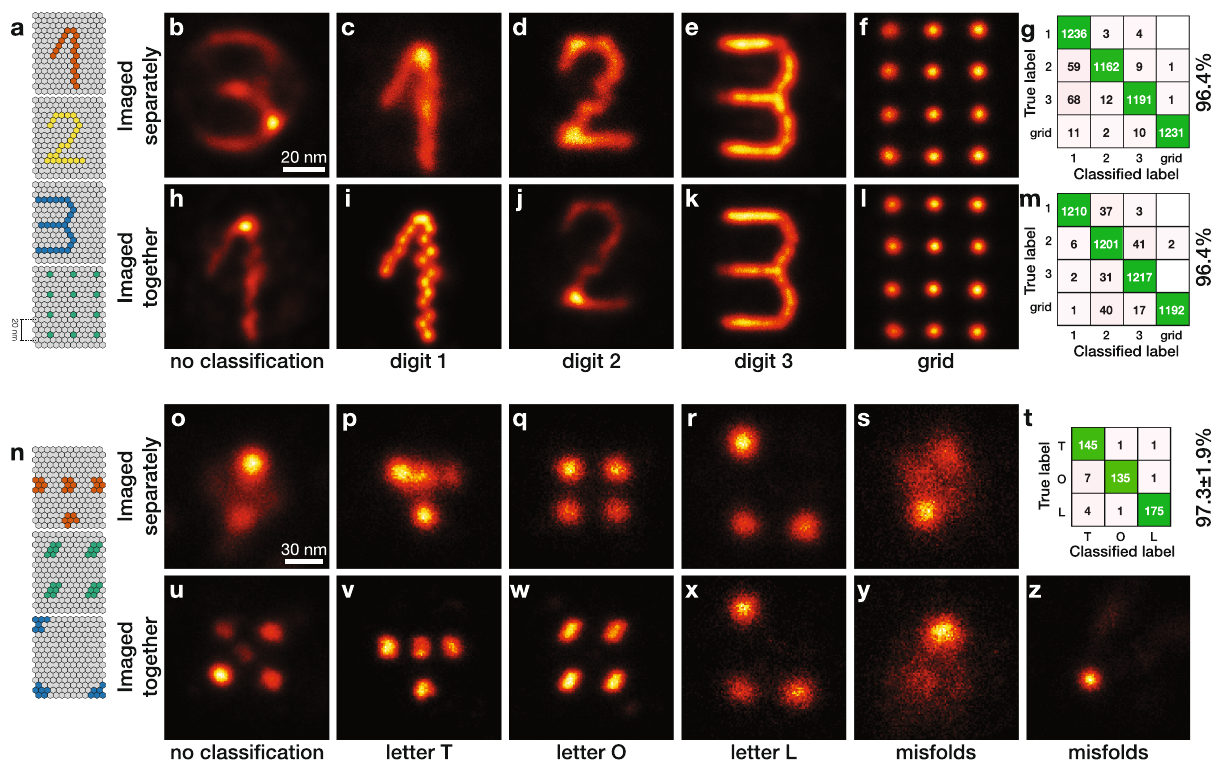
Fig. 2 Classi fi cation of experimental DNA origami datasets. a Templates of four DNA-origami designs in the digits dataset: the digits 1, 2, and 3 and a 20 nm grid. b Fusion result without classi fi cation of 2000 particles (randomly selected from a set of 10,000 images, 2500 per class). This data is imaged separately per class and combined into one dataset prior to the classi fi cation. c – f The four classes resulting from the classi fi cation of 5000 images (randomly selected from a set of 10,000 images, 2500 per class) containing 1374, 1179, 1214, and 1233 particles, respectively. g Confusion matrix of the classi fi cations c – f with an overall performance of 96.4%. h Fusion result without classi fi cation of 2000 particles imaged in one FOV. i – l The four classes resulting from the classi fi cation of 5000 particles images in one FOV, containing 1219, 1309, 1278, and 1194 particles, respectively. m Confusion matrix of the classi fi cations i – l , with an overall performance of 96.4%. n Templates of three DNA-origami designs in the letters dataset: letters T, O, and L. o